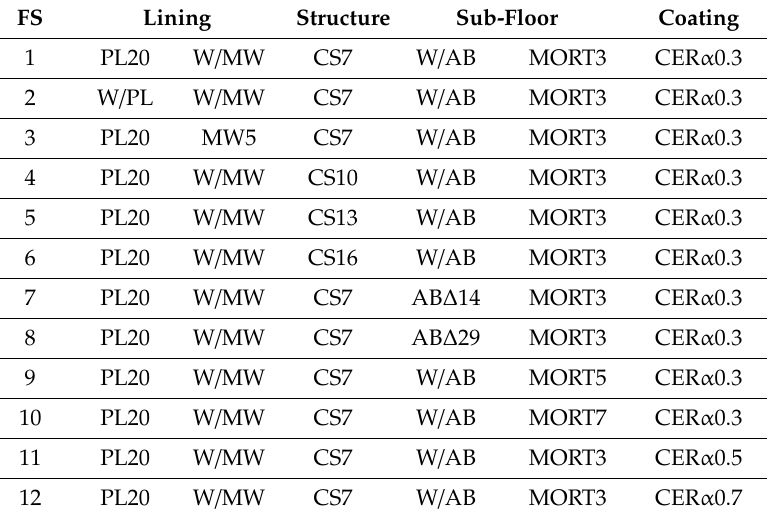
Table 11. Floor systems (FS) considered in numerical simulations.